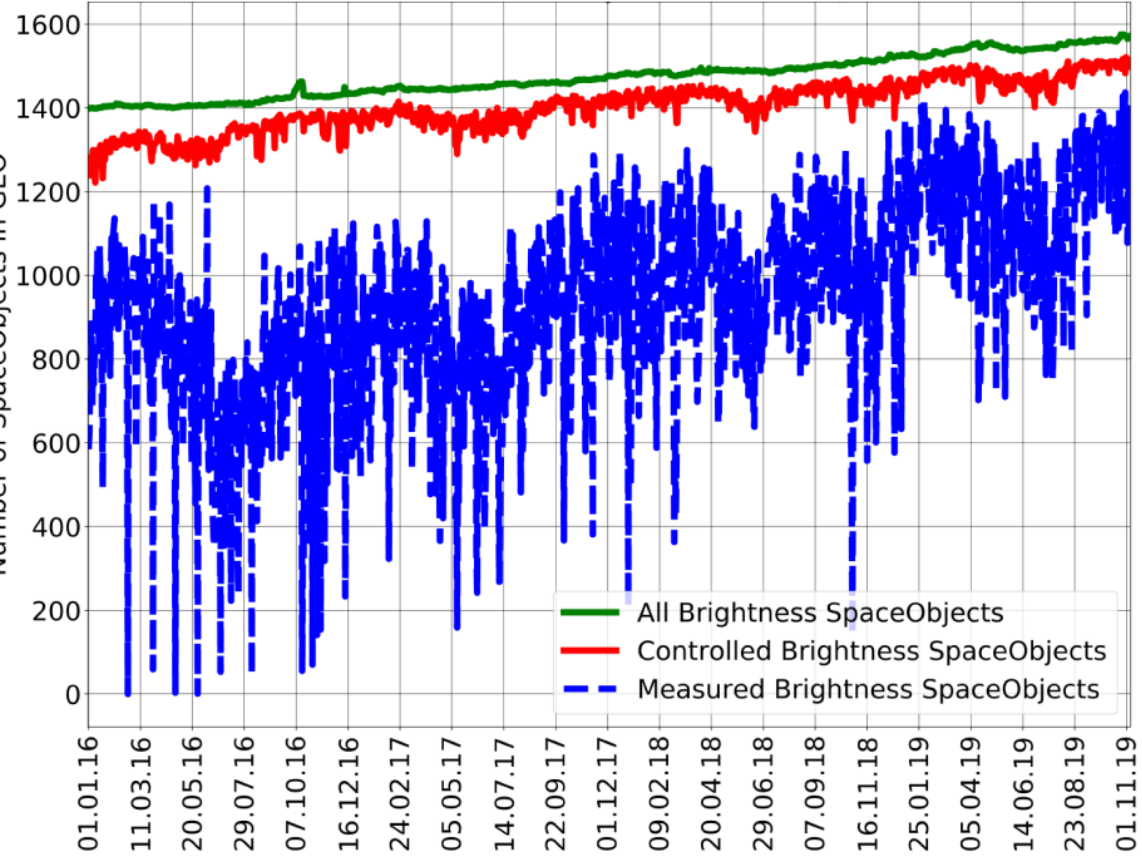
Figure 2. Status of the ISON catalog of bright GEO objects in 2016-2019. Here are shown the parameters of the catalogue of bright GEO objects for the 4 years period. Curves of different color indicate total number of objects brighter 15.5 m (green), number of objects measured during current night (blue), and number of objects with accurate orbits (red). Vertical axis - number of objects, horizontal